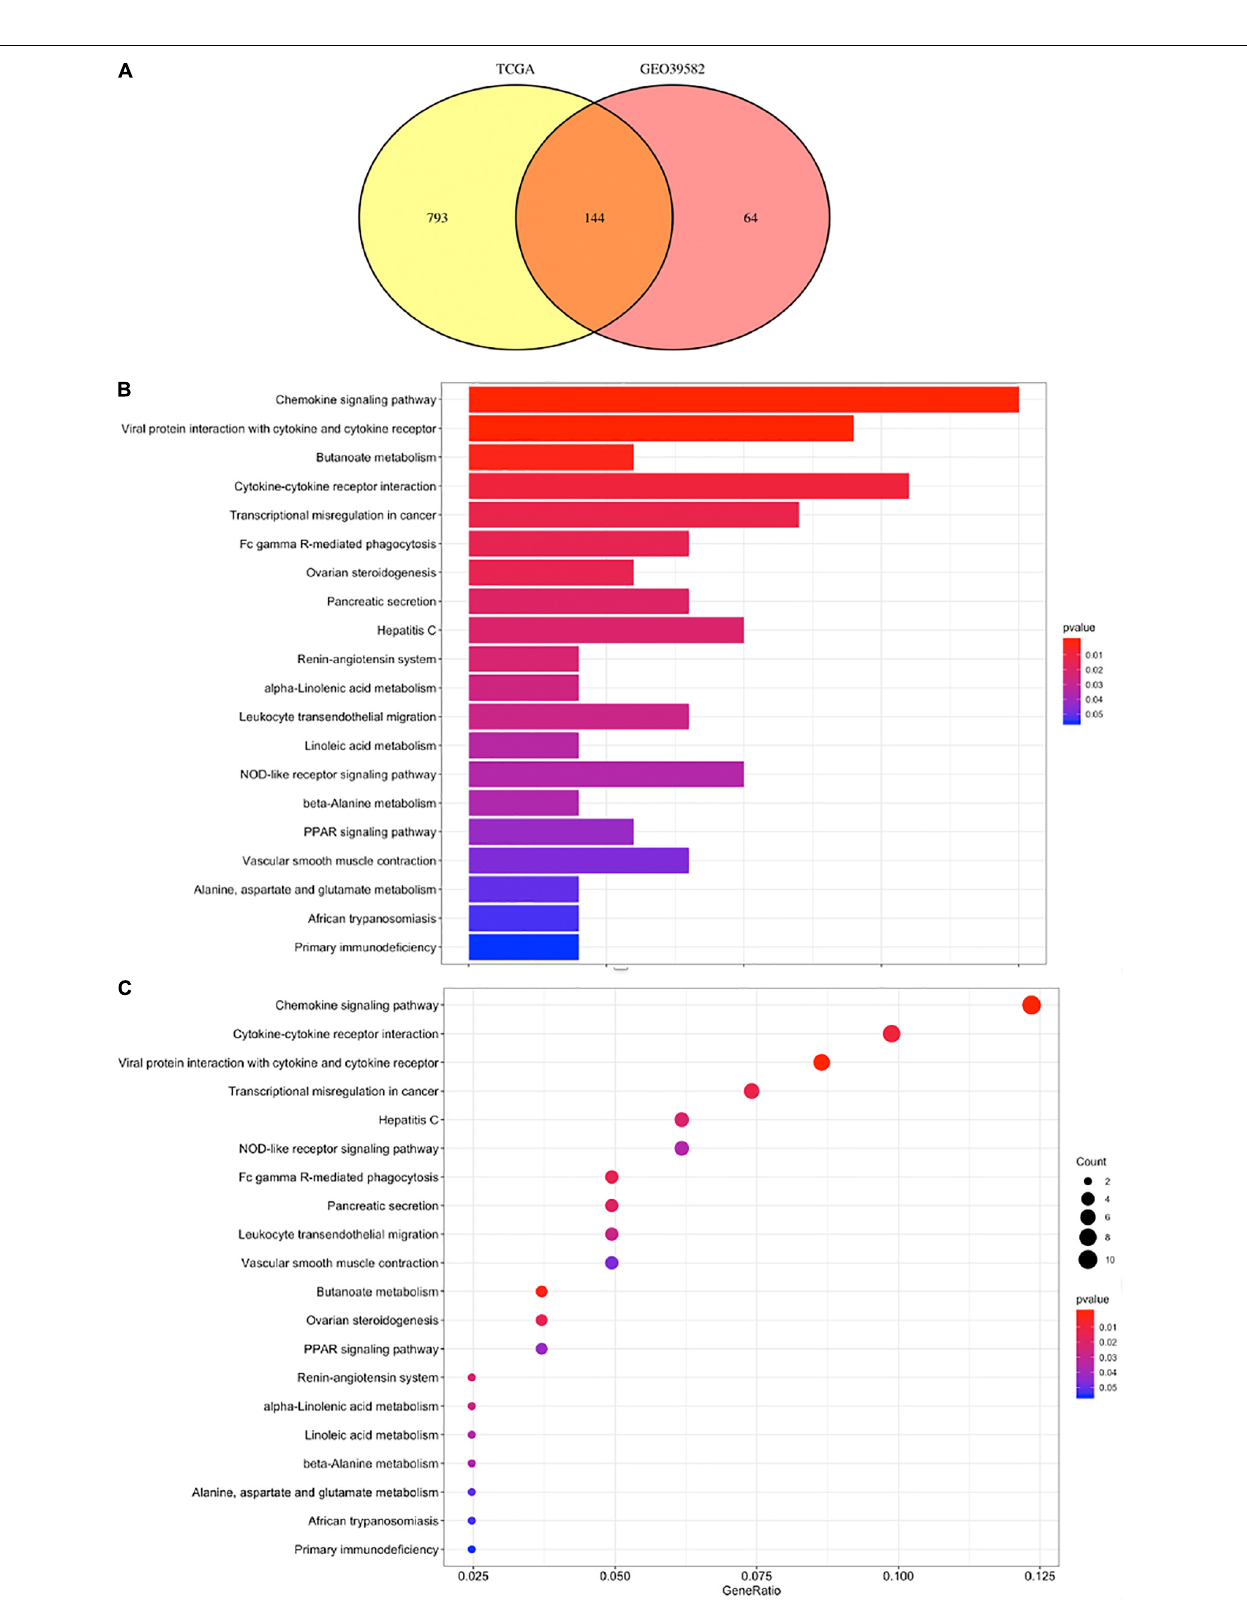
FIGURE 4 | DEGs between BRAF wild-type and BRAF mutated patients (A) and their KEGG graphs (B,C) .